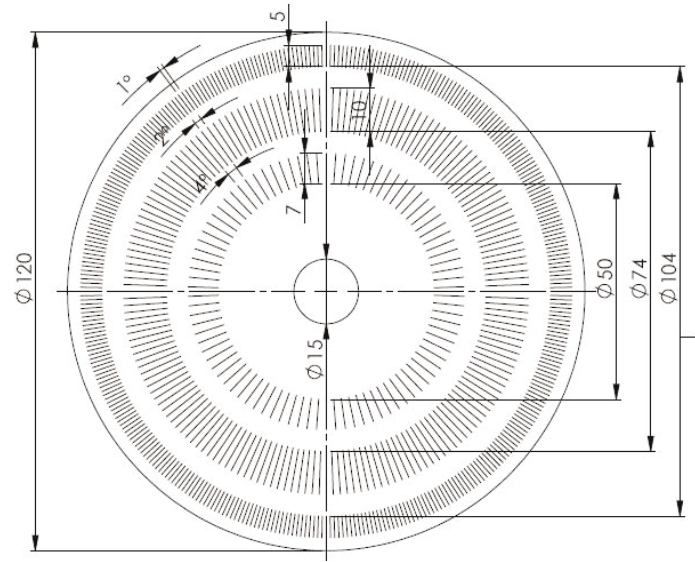
Fig. 3. Drawing a circular scale for experimental